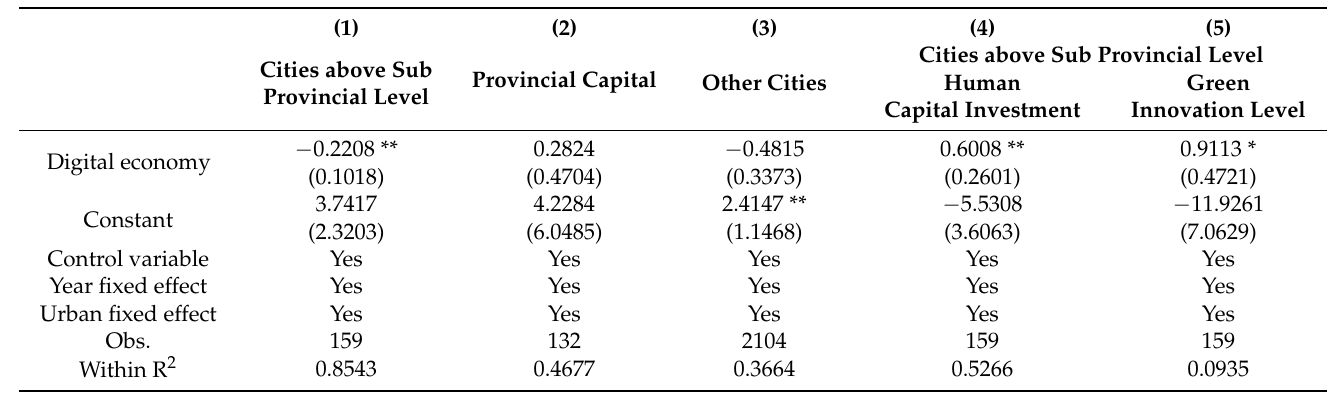
Table 8. Regression results of samples of cities with different administrative